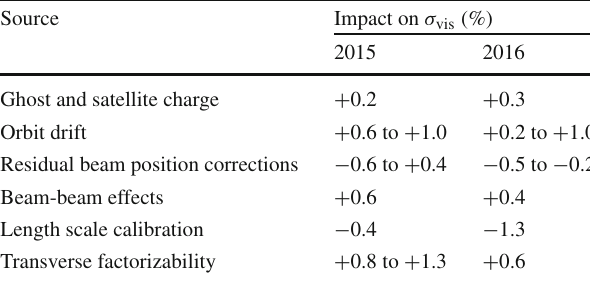
Table 3 Summary of the BCID-averaged corrections to σ vis (in %) √ s = 13TeV in 2015 and obtained with the vdM scan calibrations at 2016. When a range is shown, it is because of possible scan-to-scan variations.Toobtaintheimpacton σ vis ,eachcorrectionisconsecutively included, the fits are redone following the order below, and the result is compared with the baseline. The impact from transverse factorizability is obtained separately (as discussed in Sect.